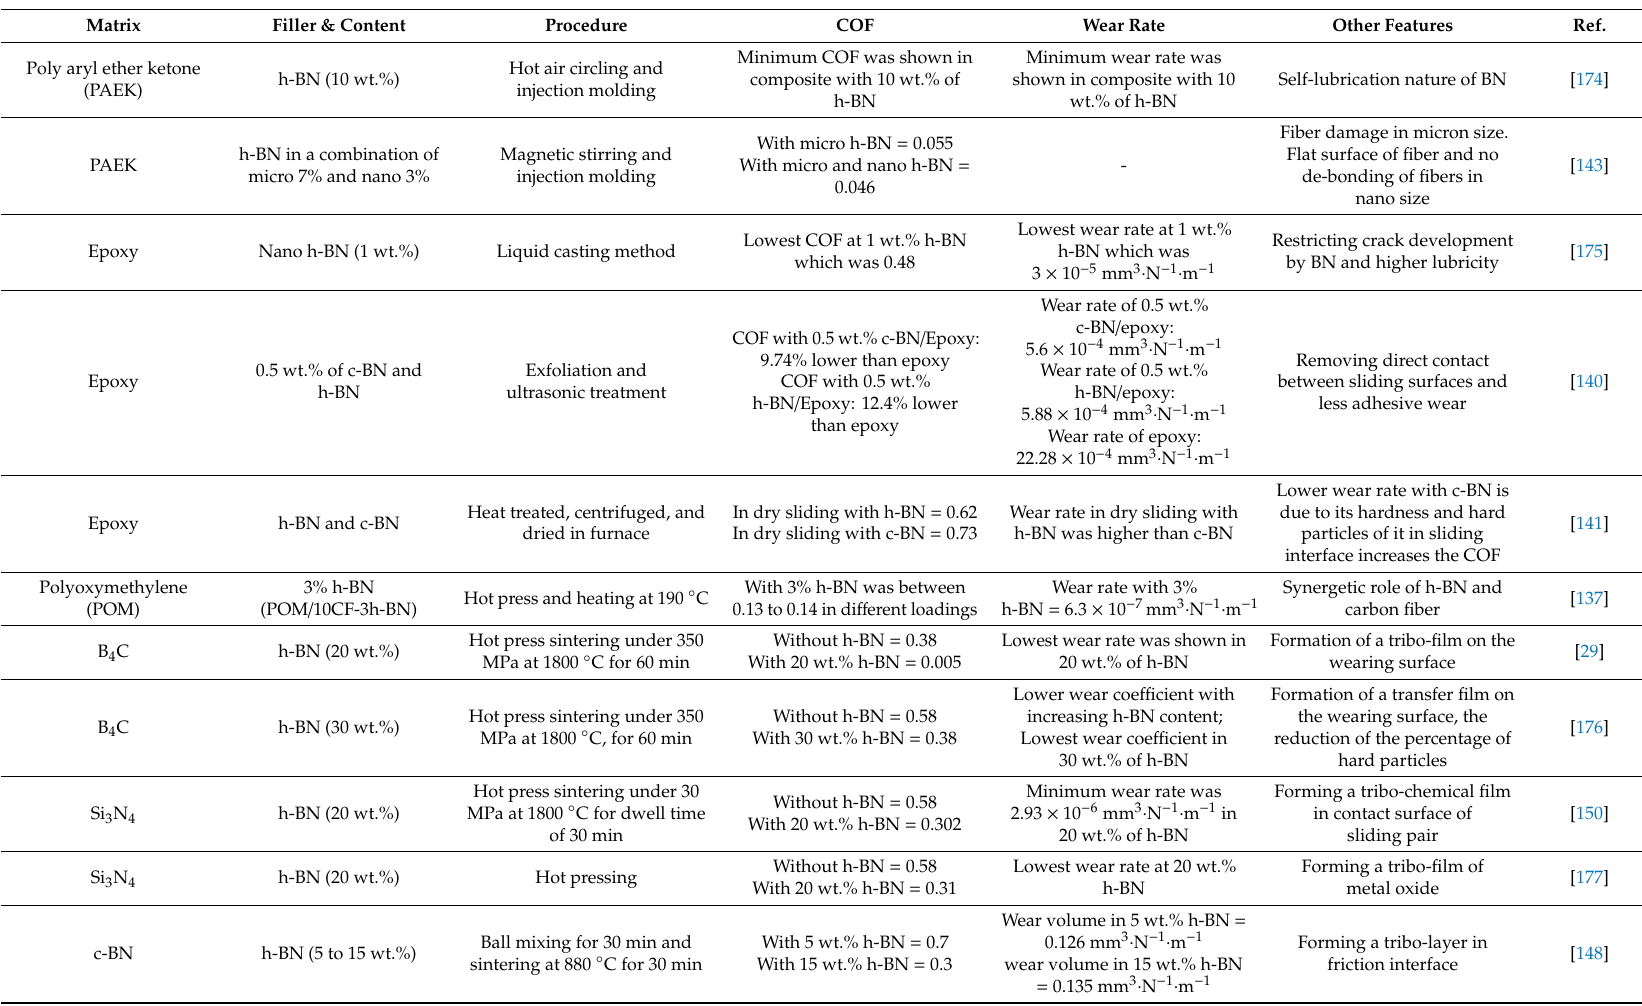
Table 2. Summary of recent developments in composites reinforced with h-BN for enhancing tribological